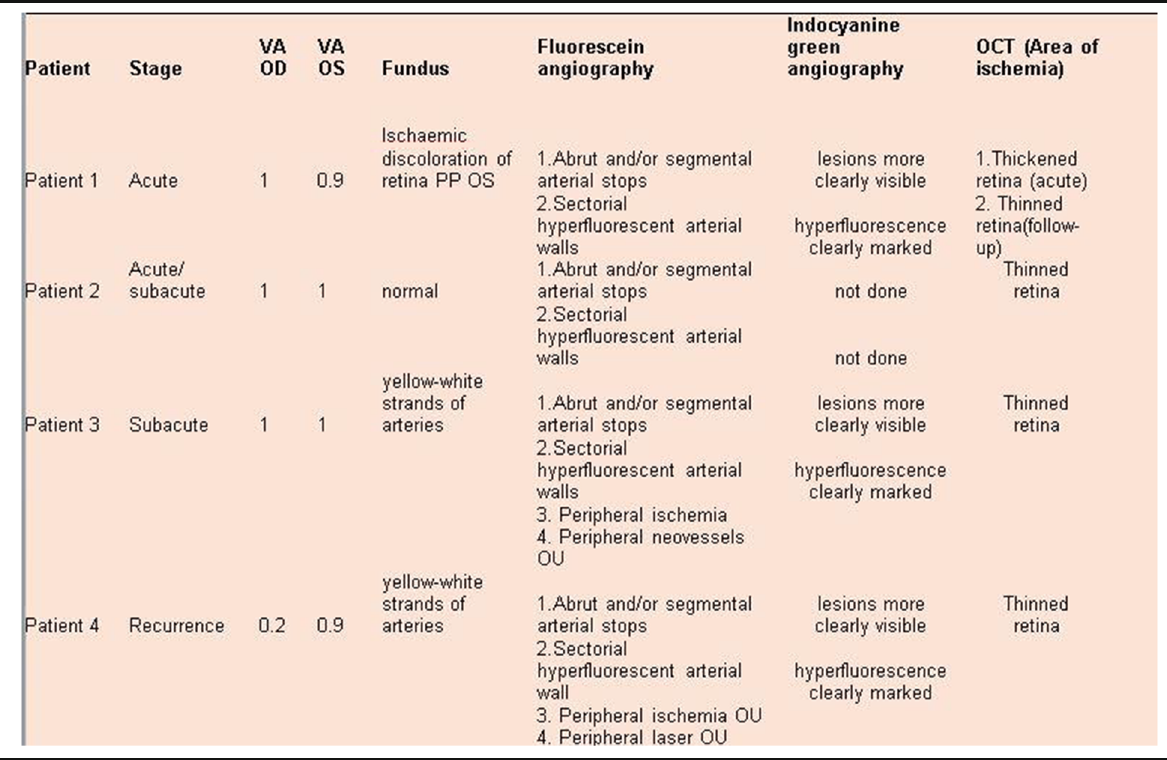
Table 2 Ophthalmic, angiographic and OCT data